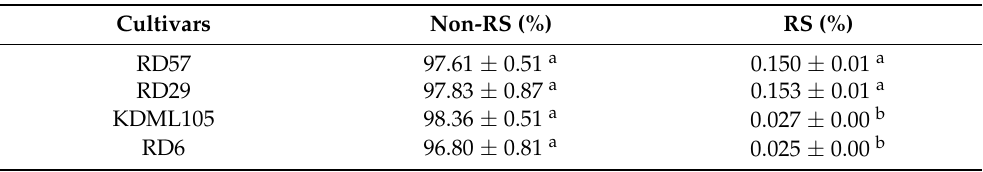
Table 6. The non-resistant starch (Non-RS) and resistant starch (RS) contents of the four Thai commercial rice starches with different pasting